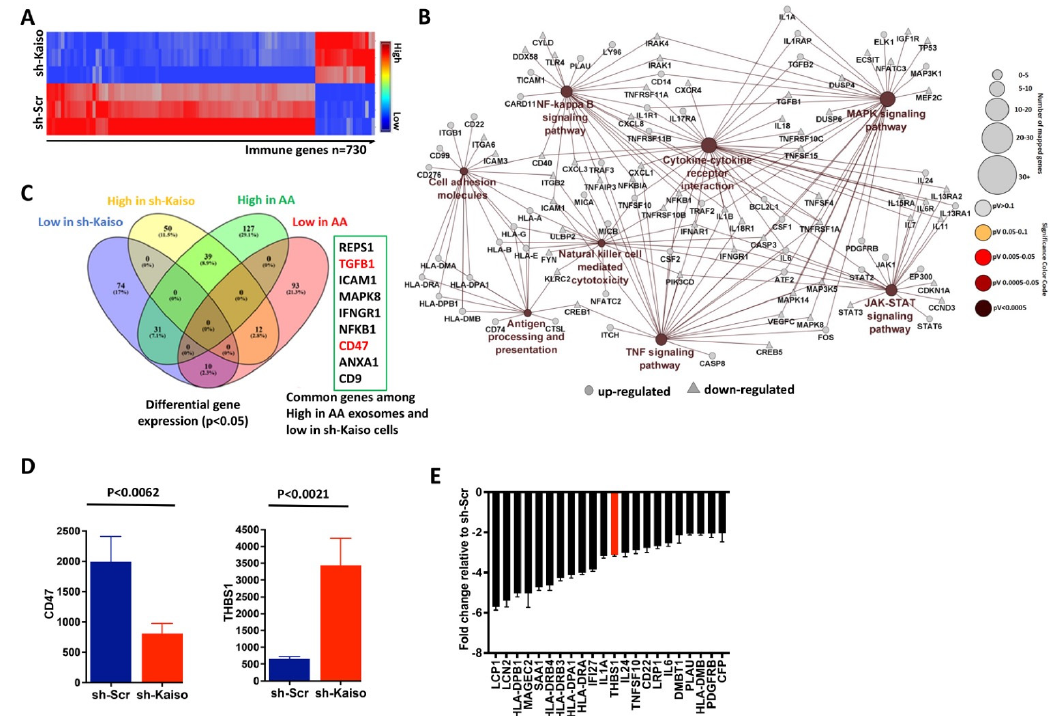
Figure 2. Kaiso represses the expression of several immune genes, including THBS1. ( A ). Hierarchical clustering of differentially expressed genes from PanCancer Nanostring Immune Profiling showed that there were fewer immune genes expressed in sh–Kaiso cells as compared to control sh-Scr cells. ( B ). Cytoscape analysis shows that genes interact through the chemokine signaling pathway, the cytokine–cytokine receptor pathway, the MAPK signaling pathway, and the NOD–like receptor signaling pathway, and the NF–kappa B signaling pathway was downregulated in sh-Kaiso cells as compared to sh-Scr cells. ( C ). A Venn diagram shows the association of immune genes between genes that were upregulated in AA exosomes and genes downregulated in sh-Kaiso cells (identified by color code). A total of 31 genes, including CD47 and TGFB1, were common genes among these two groups. ( D ). Kaiso-depleted cells showed significantly lower expression of CD47 with significantly higher expression of THBS1 as compared to sh–Scr cells. The statistical method used was the two–tailed paired t test. ( E ). Nanostring immune profiling showed that Kaiso repressed several genes, including THBS1, based on the downregulated gene expression in sh–Scr